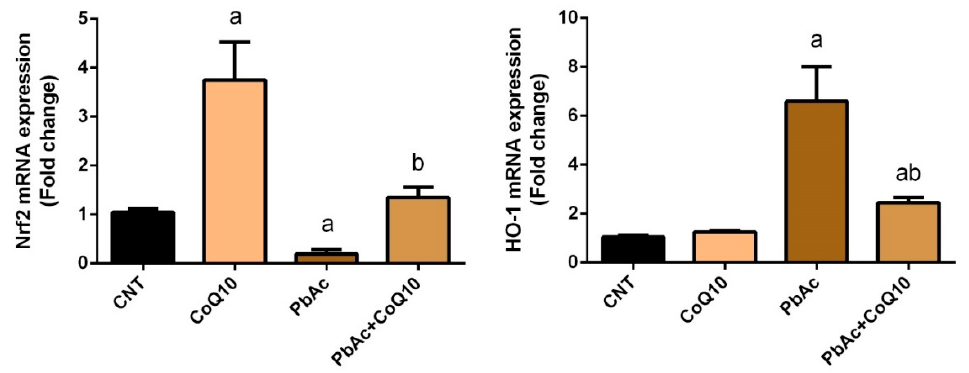
Figure 4. Effects of coenzyme Q10 on cortical Nrf2 and HO-1 mRNA expression following lead acetate exposure. mRNA Data are expressed as the mean ± SD of triplicate assays normalized to β -actin and expressed as fold changes (log2 scale) compared with the mRNA levels of the control group; significant changes at P < 0.05 were determined using Duncan’s post-hoc test. a significant changes compared with the control group; b significant changes compared with the PbAc injected group.